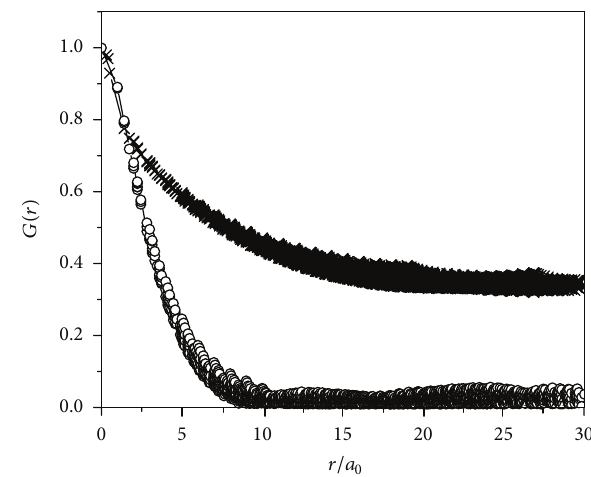
Figure 6: Typical 𝐺(𝑟) profiles. I : random history , × : homogeneous history . 𝑁 = 60 , 𝑊 = 1 , 𝑇 = 0.5 , 𝑃 = 0.1